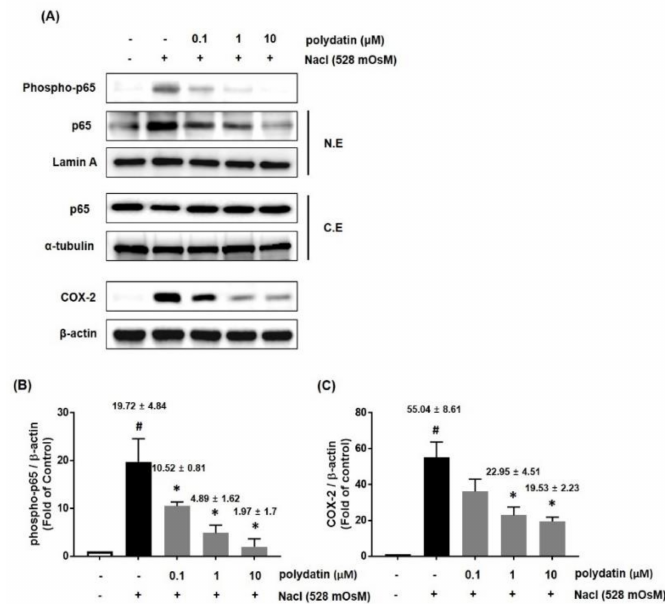
Figure 6. E ff ects of polydatin on inflammation in hyperosmolar stress-induced HCCs. HCCs cells were co-treated with the indicated concentrations of polydatin and hyperosmotic media (528 mOsM) for 1 h (p65) or 8 h (COX-2). ( A ) The protein expression of phosphor-p65 and COX-2 was analyzed by western blotting analysis. Cytoplasmic and nuclear levels of NF- κ B p65 were detected by western blotting to analyze the translocation of NF- κ B. α -tubulin and Lamin A were used as loading controls. ( B , C ) The relative intensities are expressed as the ratio of phosphor-p65, nuclear p65, and COX-2 to Lamin A or β -actin. Data are the mean ± SEM of three independent experiments for all groups. # p < 0.05, significantly di ff erent from the untreated group, * p < 0.05, significantly di ff erent from the hyperosmotic-treated